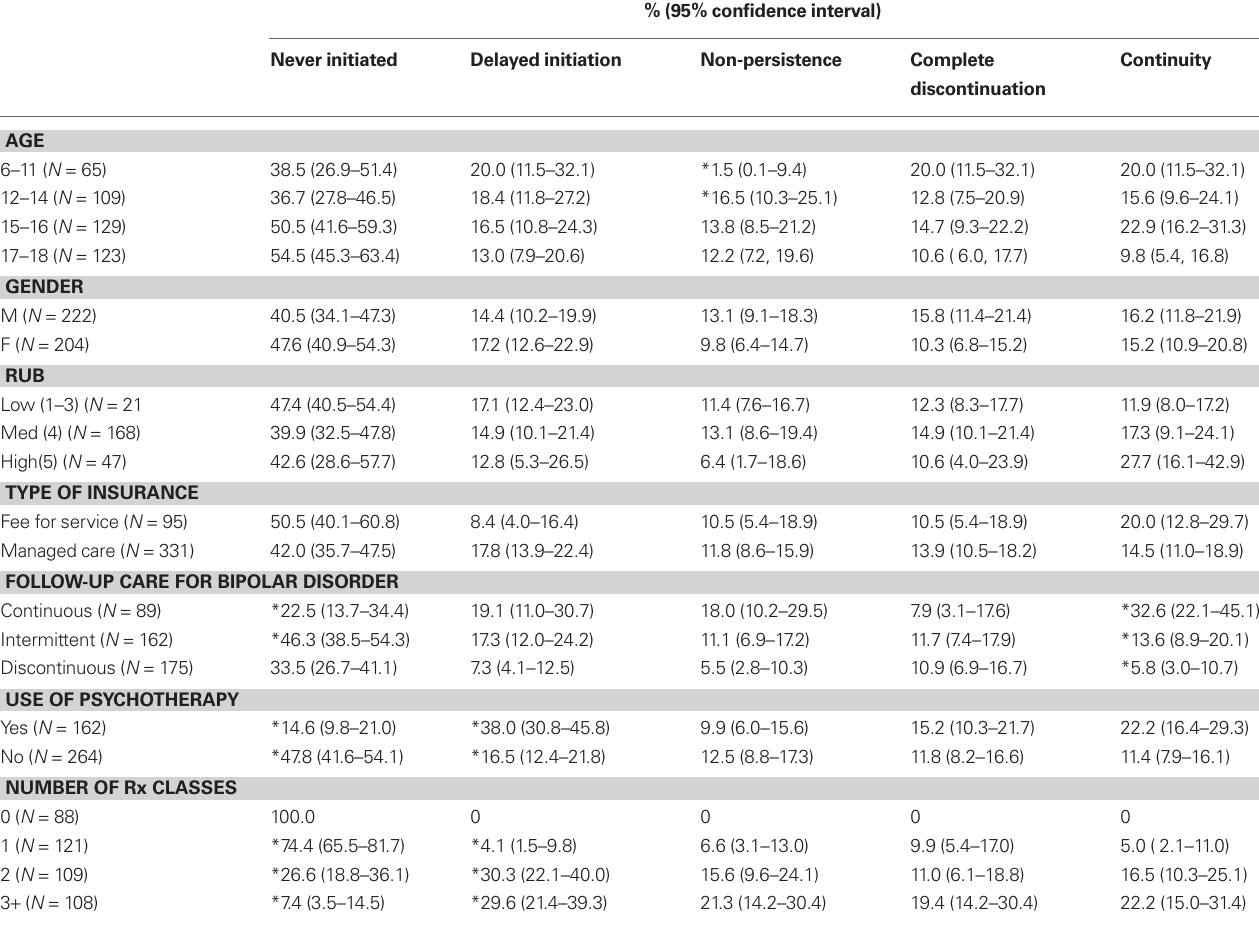
Table 2 | Patterns of mood stabilizing prescription fills by demographic, clinical characteristics, and insurance plan characteristics ( n =